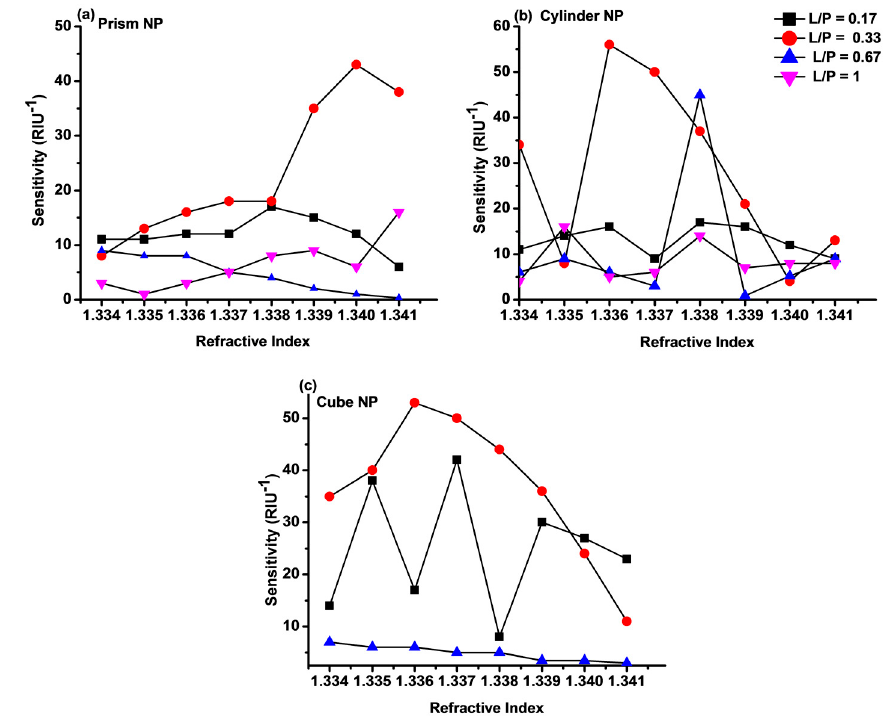
Figure 7. Sensitivity of the hybrid Au-G nanostructure with ( a ) prism; ( b ) cylindrical; and ( c ) cubic NPs at different L/P ratios as a function of the refractive index.